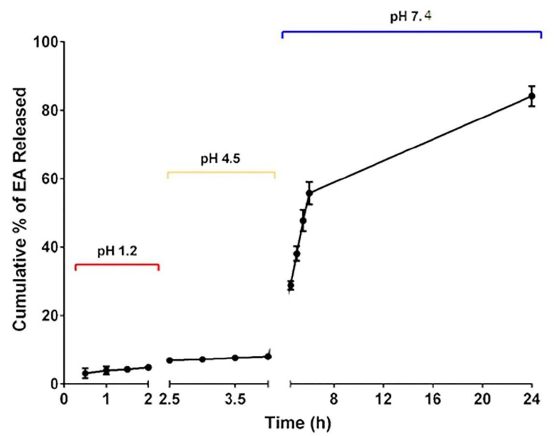
Figure 2. Release profile of EA MPs at different pH values (1.2, 4.5, and 7.4).